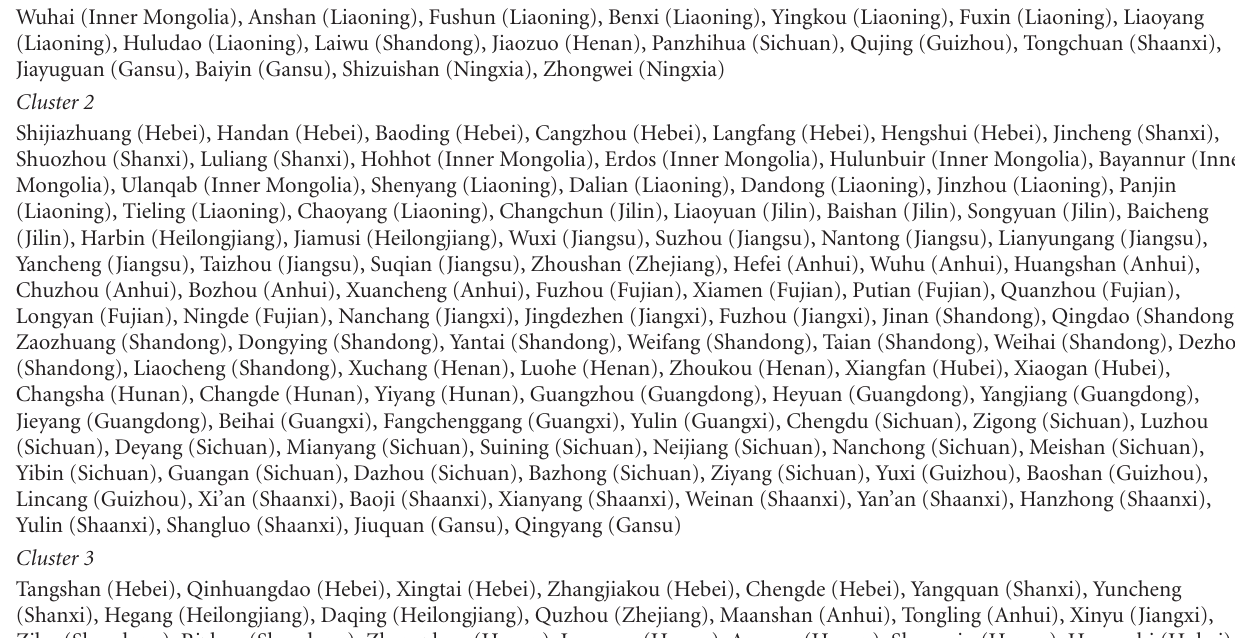
Table 5: Clustering membership of the finite mixture